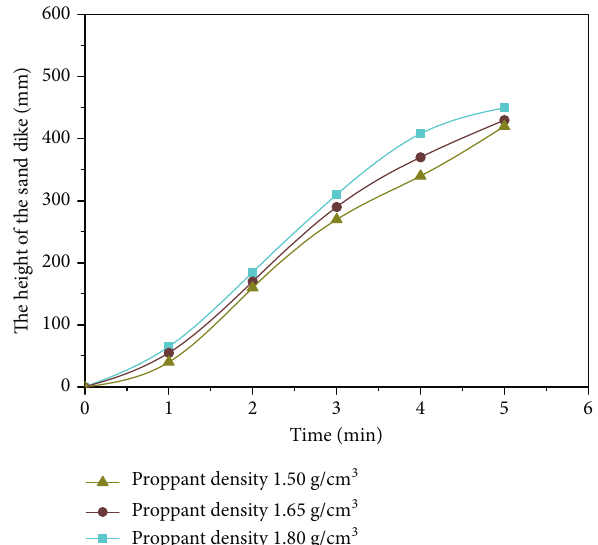
Figure 9: The height of the sand dike in sand carrying by slickwater with di ff erent proppant densities.